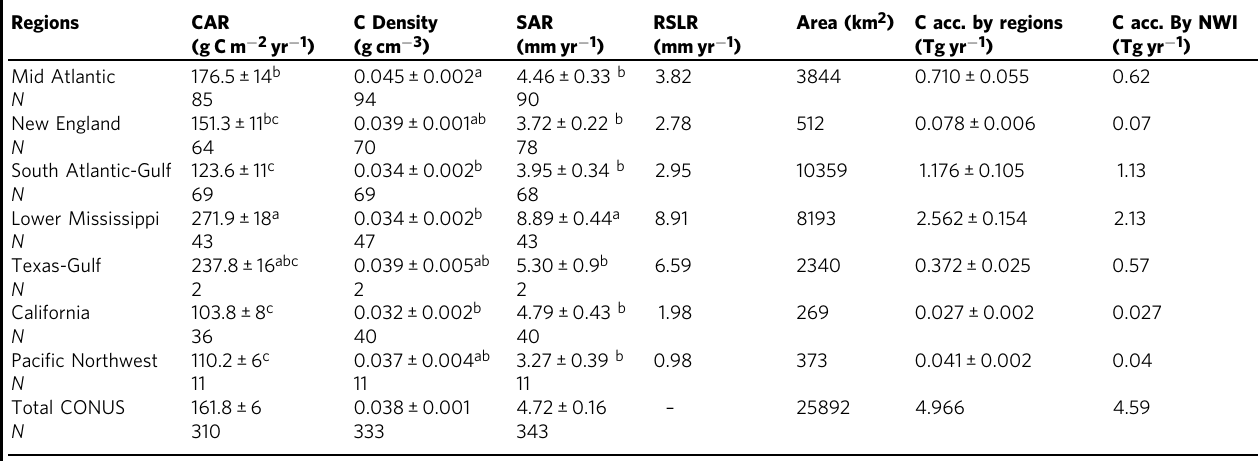
Table 1 The C accumulation rate (CAR), C density, sediment accretion rate (SAR), tidal wetland area, and annual CAR in different regions of the conterminous United States (mean ± s.e.m.).